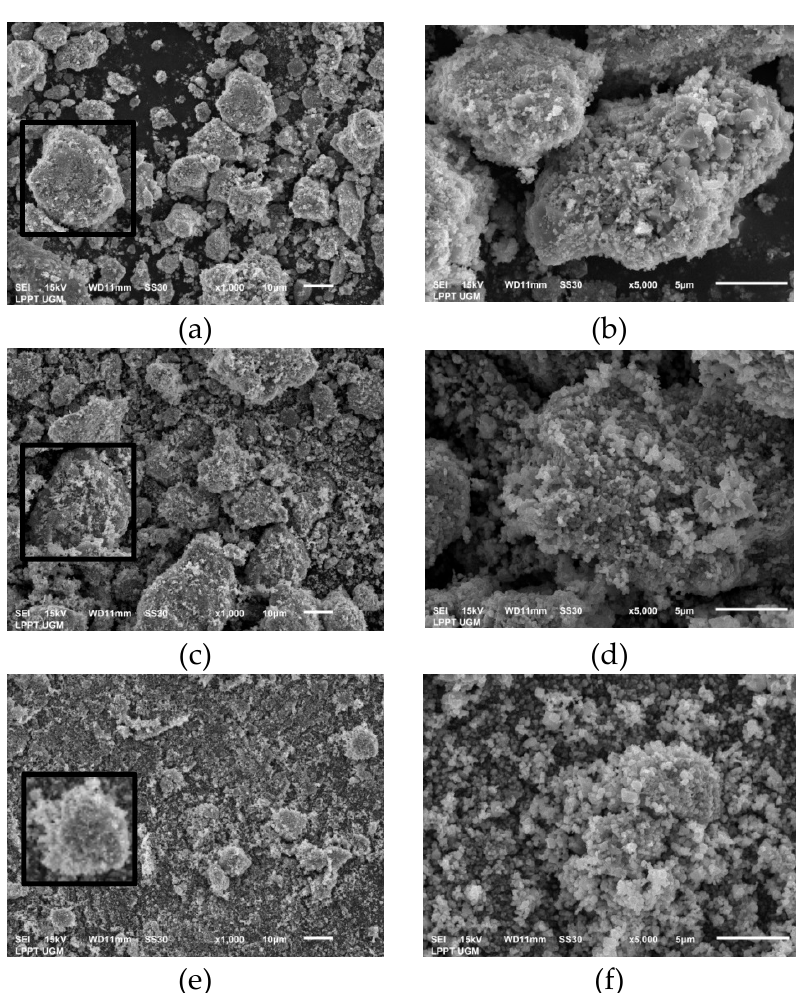
Figure 10. SEM images of RNCA material: ( a , b ) RNCA ‐ HA; ( c , d ) RNCA ‐ NA; ( e , f ) RNCA ‐ SA. Metals 2019 , 9 , x FOR PEER REVIEW